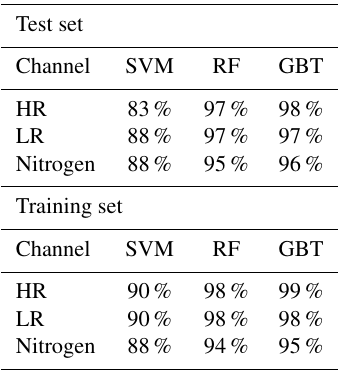
Table 1. Accuracy scores for the training and the test set for SVM, RF, and GBT models. Results are shown for HR, LR, and nitrogen channels.